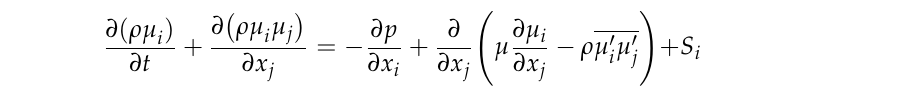
Figure 4. Mesh on the propeller and aeration pipe. 2.4. Grid Convergence Let Y + be the non-dimensional wall distance defined as Y+ ≡ 𝑢 ∗ 𝑦/𝜈 , where 𝑢 ∗ is the friction velocity at the nearest wall, 𝑦 the distance to the nearest wall, and 𝜈 the local kinematic viscosity of the fluid. In this sub-section the sensitivity of numerical results with respect to Y+ is studied. Generally, the range of dimensionless wall distance Y + ≈ 30~100 is acceptable for blade surfaces. Table 2 lists the error of the thrust coefficient K t and torque coefficient 10 K q compared with the test value with different Y + value. It can be seen that three errors reach minimum when the Y + is equal to 60. Therefore, we set Y + = 60 in the meshing setup. Table 2. Results for the Y+ for selection. Y+